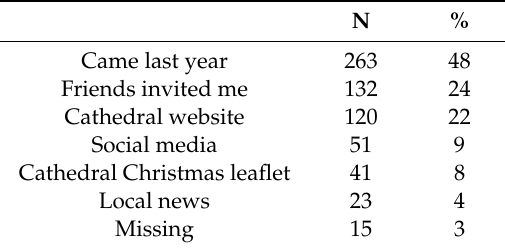
Table 7. Hearing about the service.